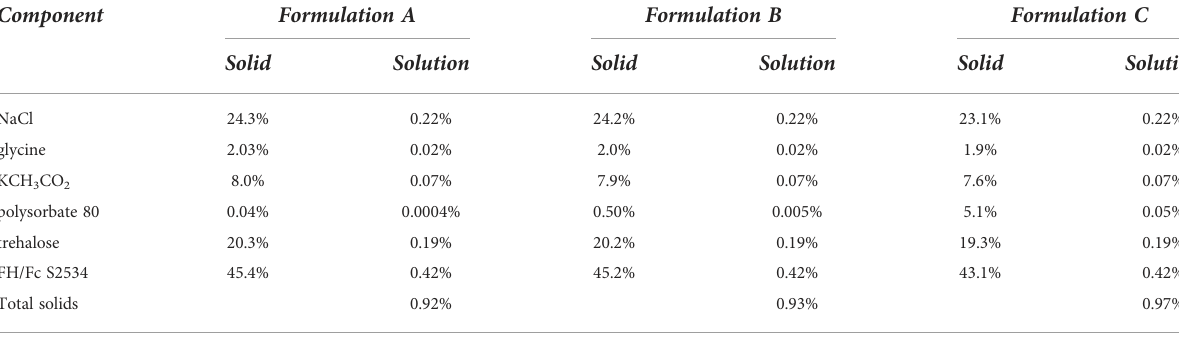
TABLE 2 Composition of formulation solutions and resulting lyophilized and spray dried